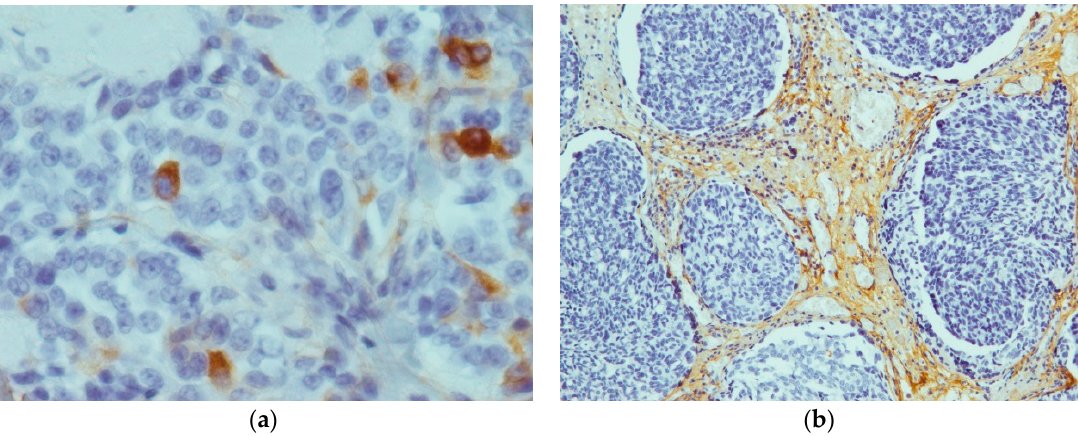
Figure 1. Staining results of tenascin C: ( a ) 40× magnification, showing cytoplasmic staining; ( b ) 10× magnification, depicting staining of the extracellular matrix and the lymph follicle-like accumulation of tumor cells.